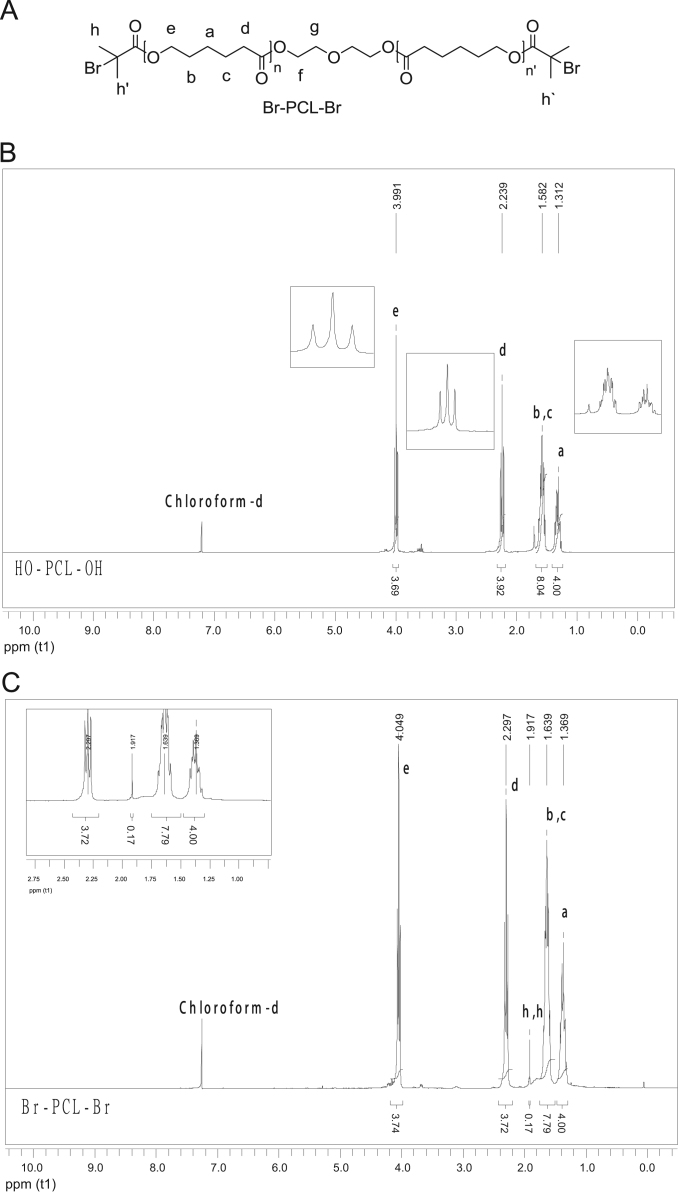
Macroinitiator Br-PCL-Br structure (A) and 1H NMR (CDCl3, 300 MHz, D) spectra of PCL-diol (B) and Br-PCL-Br (C).